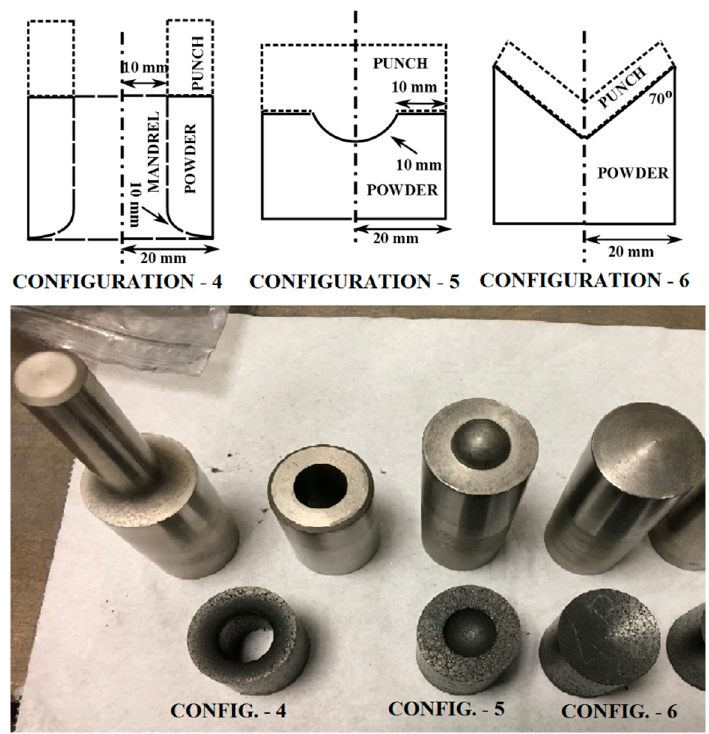
Figure 14. Die/punch configurations used for verification purposes.